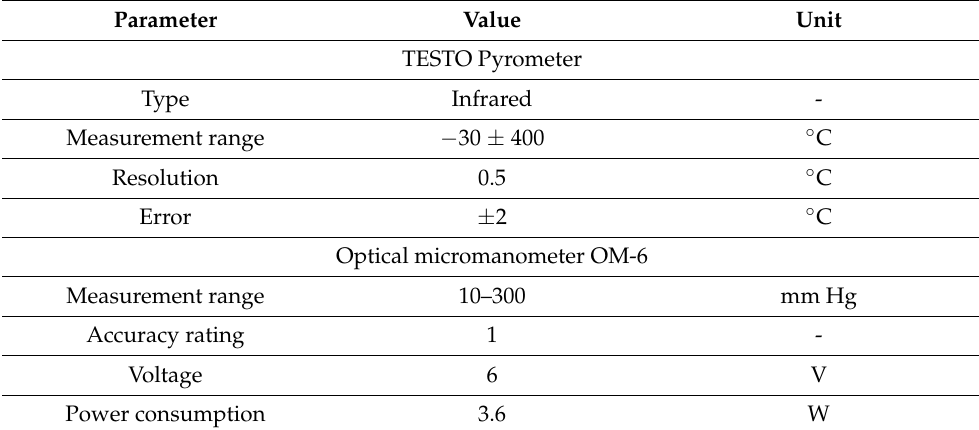
Table 2. Characteristics of portable devices.